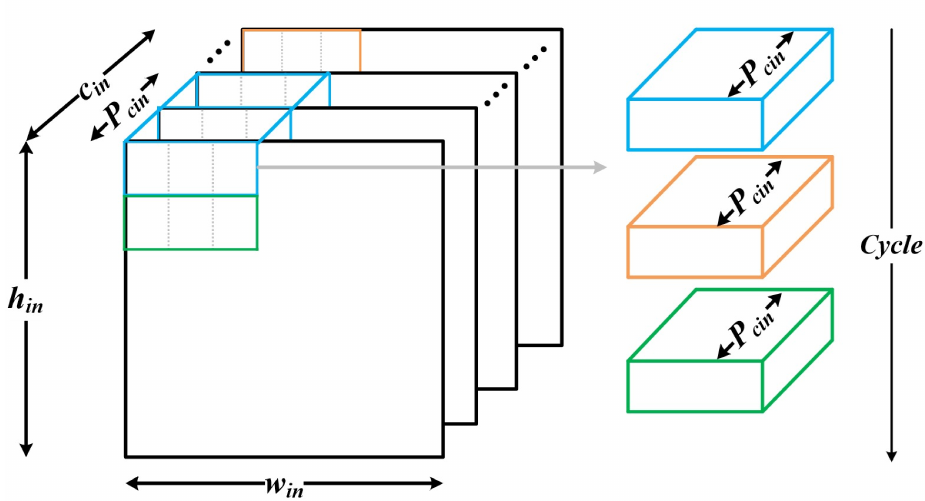
Figure 2. Data scheduling example of the first parallelism scheme.